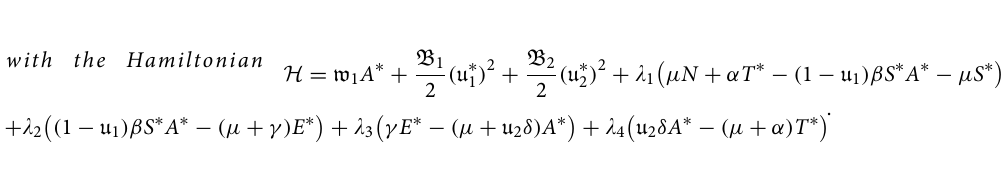
Figure 2. Local and global stability of the model animosity-free equilibrium point whenever R 0 =